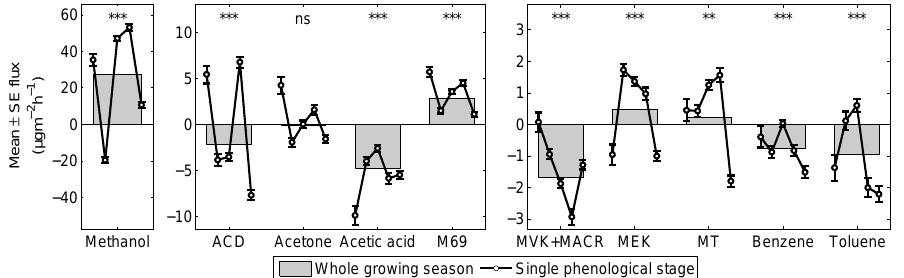
Figure 1. BVOC exchanges over the growing season. Phenological stages, from left to right: G, L, S, R1 and R2. Stars indicate the signif- icance level of flux averages over the whole growing season. See Table 1 for compound abbreviations and Table 2 for phenological stage description. Note the varying scales used for the y